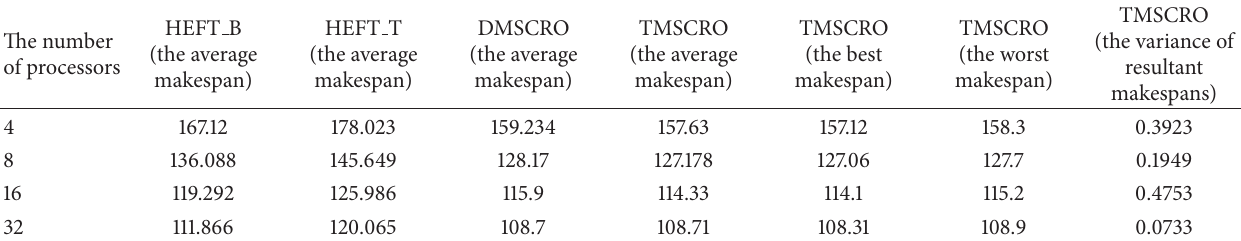
Table 12: The experiment results for the random graph under different processors, CCR = 0.2; the number of tasks is 50. The number of